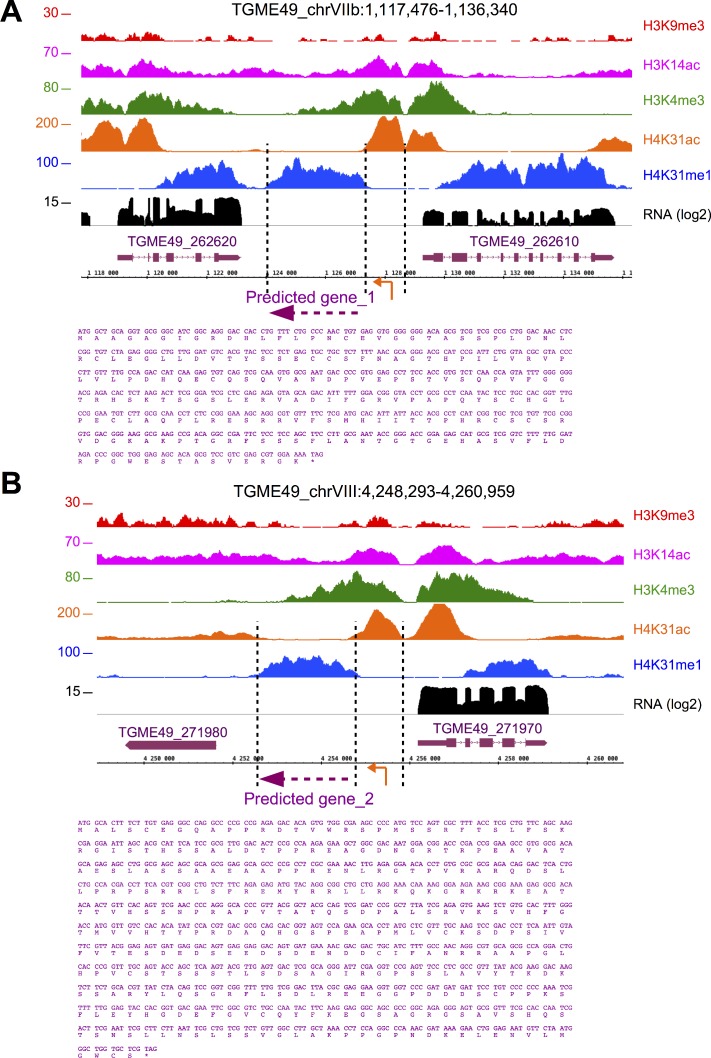
H4K31me1 explicitly predicts unannotated genes.IGB screenshot of T. gondii Chr. VIIb (a) and VIII (b) genomic regions showing reads for various histone marks as well as RNA-seq data (in black). Predicted genes are indicated in magenta along with their putative translated sequence.